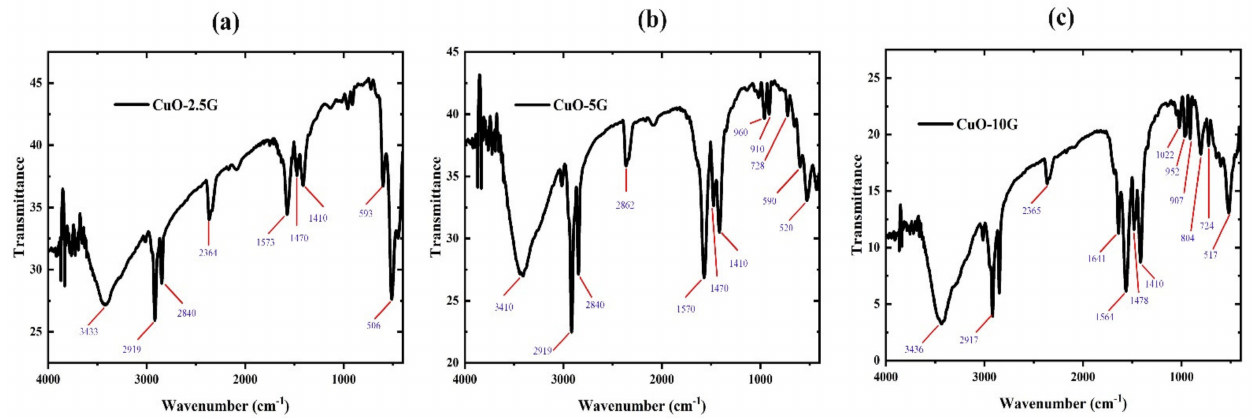
Figure 5. FTIR spectra of the samples: ( a ) CuO-2.5G, ( b ) CuO-5G, and ( c )